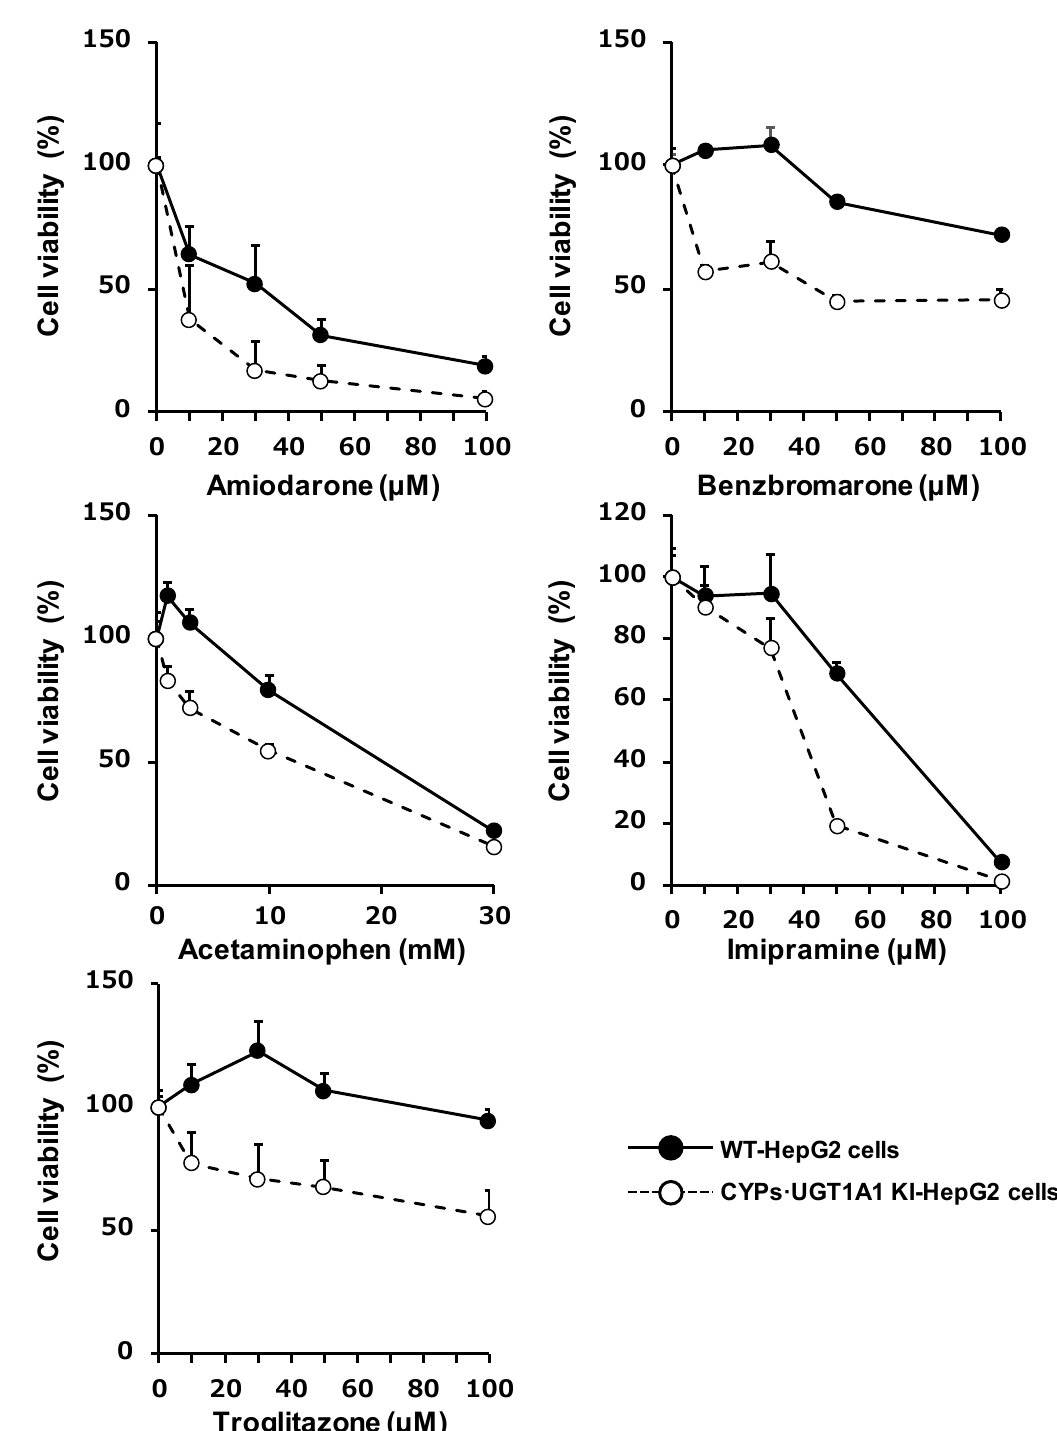
Figure 6. Drug-induced liver injury in the WT-HepG2 cells and the CYPs–UGT1A1 KI-HepG2 cells. The WT-HepG2 cells and the CYPs–UGT1A1 KI-HepG2 cells were treated with various concentrations of amiodarone, benzbromarone, acetaminophen, imipramine, or troglitazone. After 24 h, cell viability was examined by WST-8 assay. The cell viability was calculated as a percentage of the number of cells after treatment with a solvent only. The results shown are means ± SD of three technical replicates.